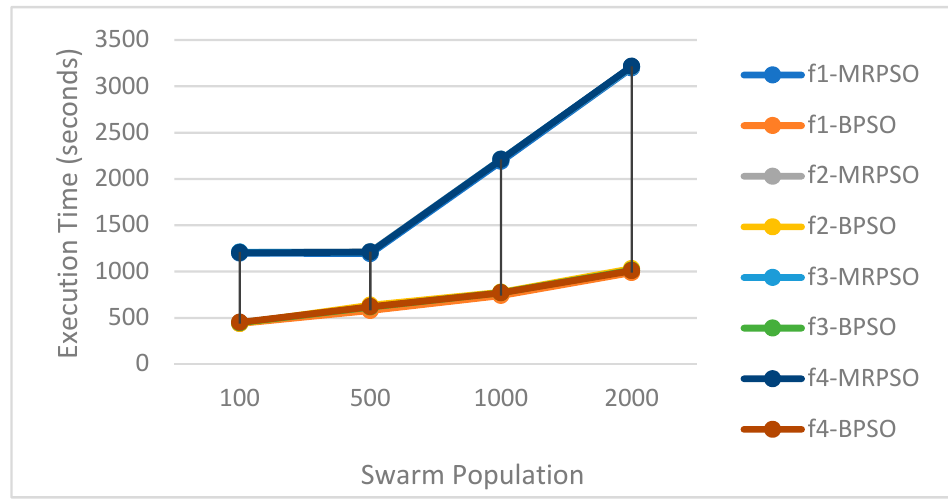
Figure 3. Running time and swarm population.